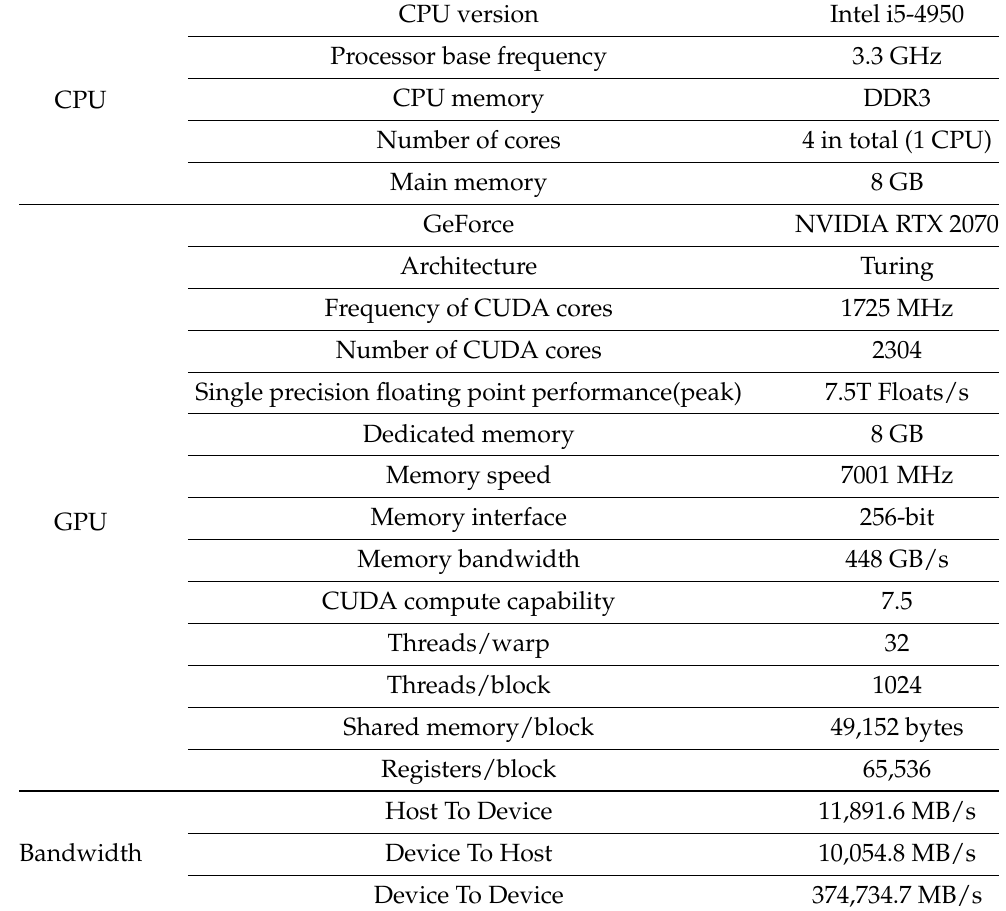
Table 1. Experimental platform hardware